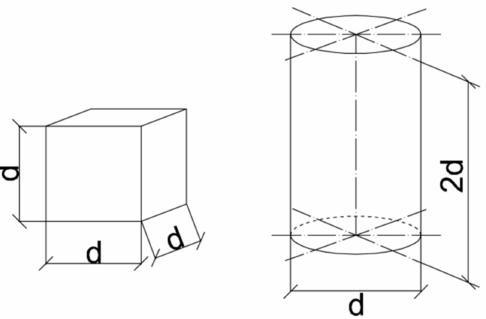
Figure 3. Types of specimens for testing tensile strength of concrete. Nominal dimensions for cubes: d = 100, 150, 200, 250, 300 mm, and for cylinders: d = 100, 113, 150, 200, 250, 300 mm, with acceptable dimension discrepancy ±